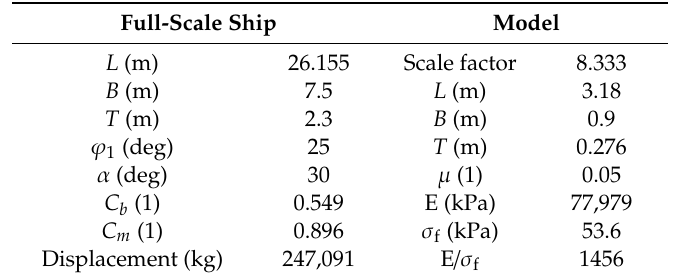
Table 2. Principal particulars of the ferry NB550 and model ship.